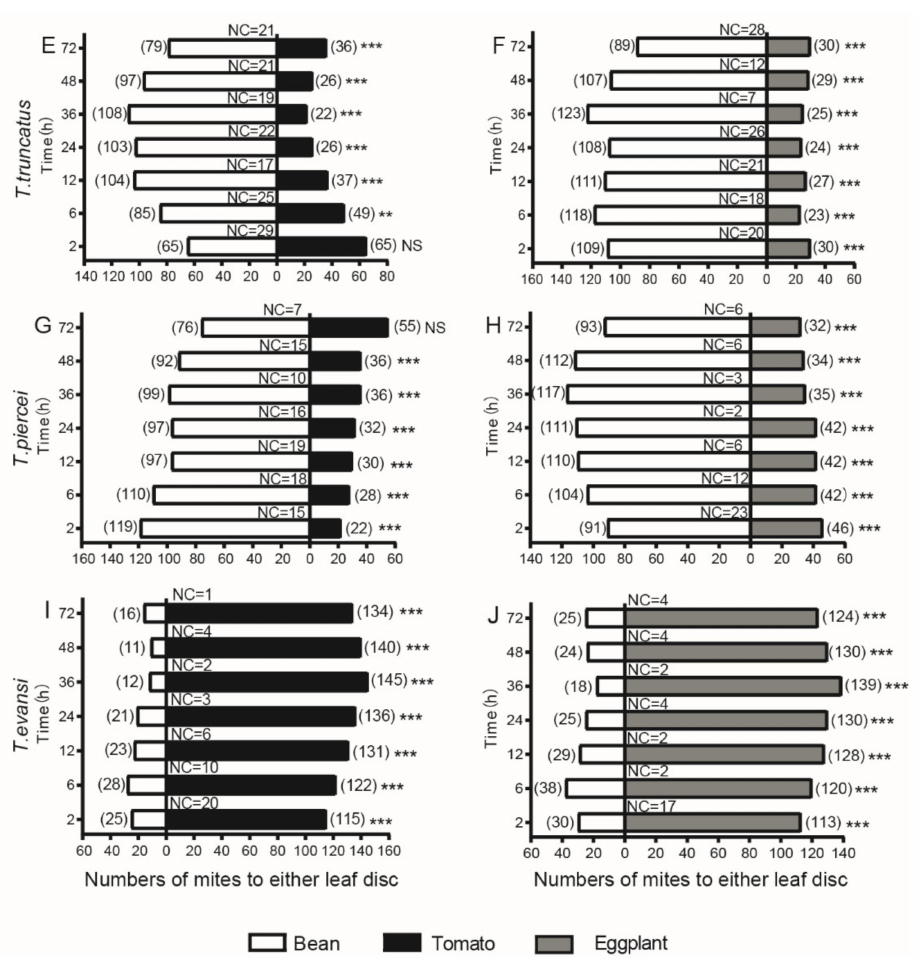
Figure 3. Selectivity of five species of spider mites to bean and tomato within 72 h. **, *** represent p < 0.01 and p < 0.001, respectively; NS, no significant difference; NC, number of individuals that made no selection. ( A , B ) for T. urticae ; ( C , D ) for T. pueraricola ; ( E , F ) for T. truncates ; ( G , H ) for T. piercei ; ( I , J ) for T. evansi